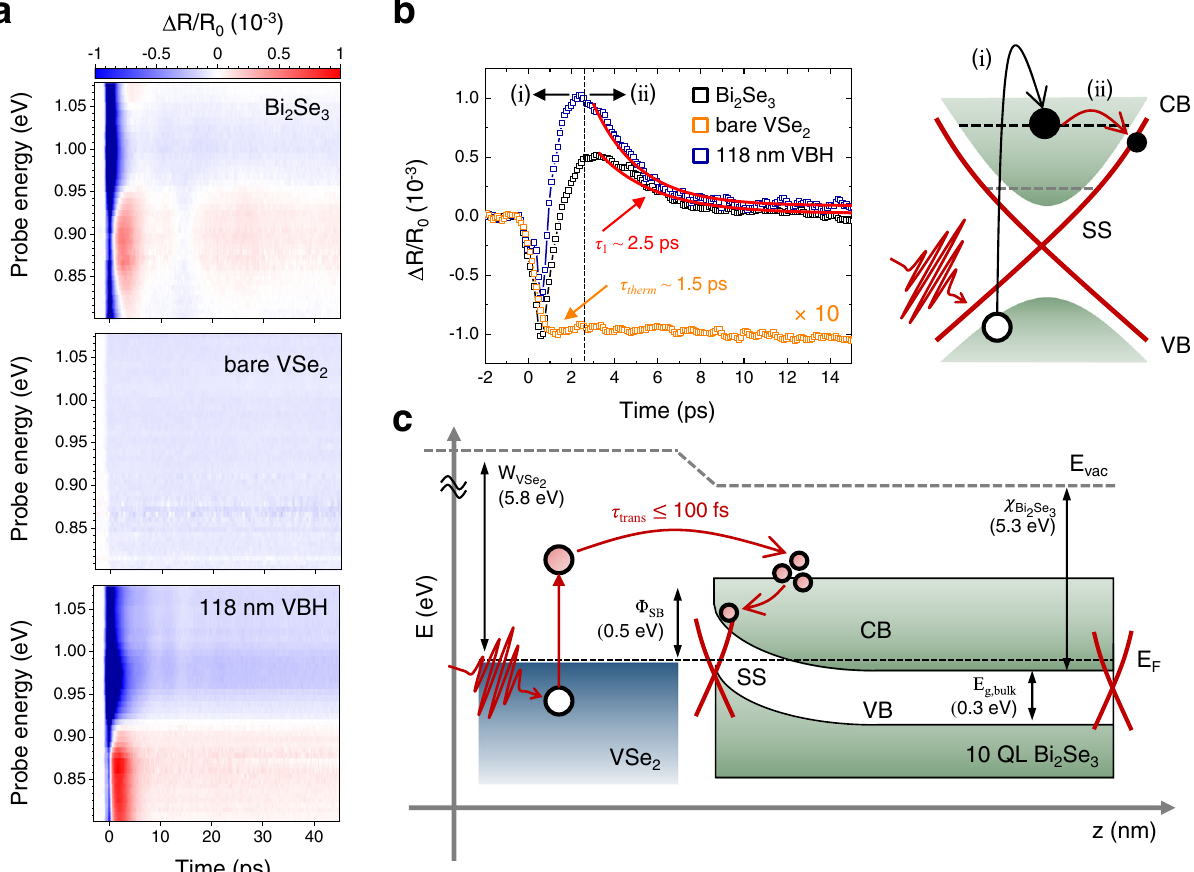
Fig. 3 Ultrafast interfacial hot electron transfer and relaxation dynamics in VSe2/Bi2Se3. a 2D plots of the transient re fl ectance (TR) spectra of 10 quintuple layer (QL) Bi 2 Se 3 , bare VSe 2 fi lm, and 118 nm VSe 2 /Bi 2 Se 3 Heterostructure (VBH). b TR traces at each sample around 0.9 eV probe energy. The thermalization time ( τ therm ) of bare VSe 2 and decay time of phonon-assisted bulk-surface scattering ( τ 1 , red curves) are listed. The stages of (i) and (ii) indicate the processes of ultrafast carrier dynamics in Bi 2 Se 3 . The CB, VB, and SS means conduction band, valence band, and surface state, respectively. c Schematic of band alignment and hot electron transfer dynamics in VBHs and. Each characteristic energy of the work function ( W ) of VSe 2 , electron af fi nity ( χ ), and bandgap ( E g ) of Bi 2 Se 3 is shown according to previous studies 11,14,62